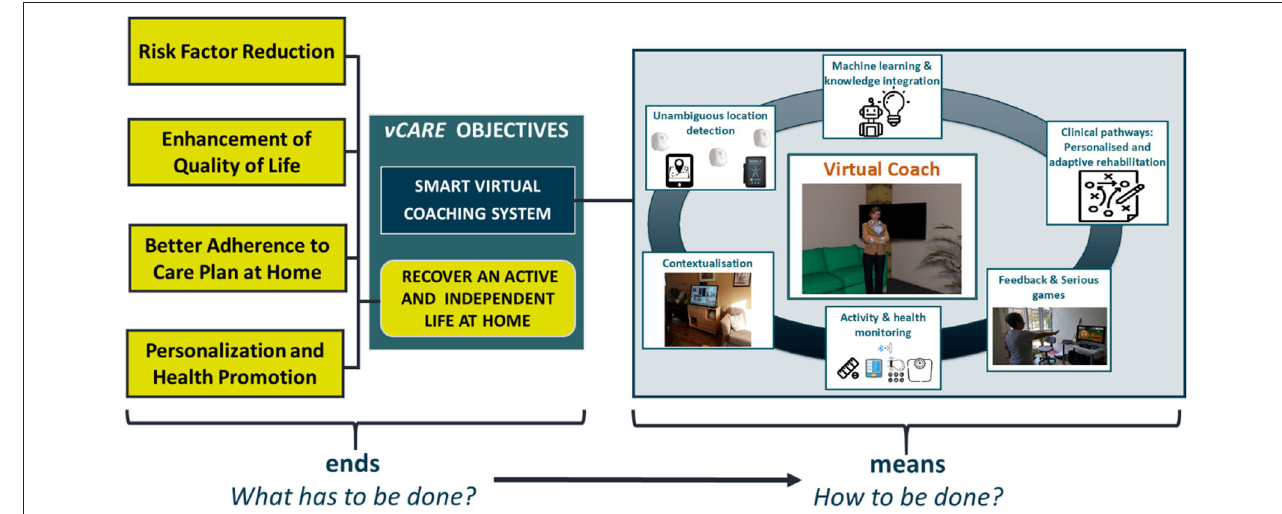
FIGURE 1 | vCare’s ends and